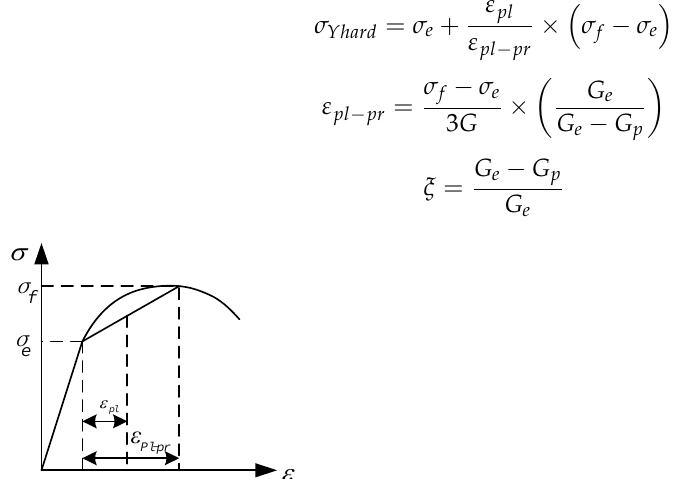
Figure 3. Diagram of the RHT material strain and hardening effect.